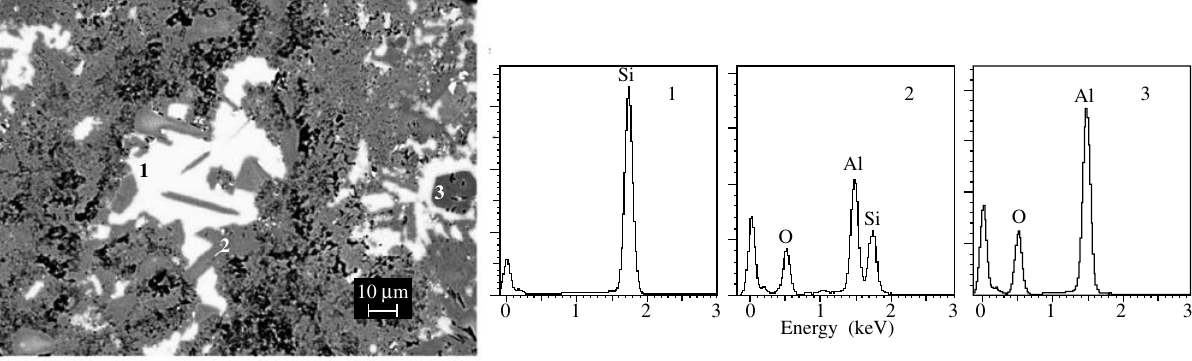
Figure 5. SEM micrograph of the sample pyrolysed at 1450 °C/2 h using back scattered electrons showing Si particles embedded in a Si, Al, O matrix, as determined by EDS.